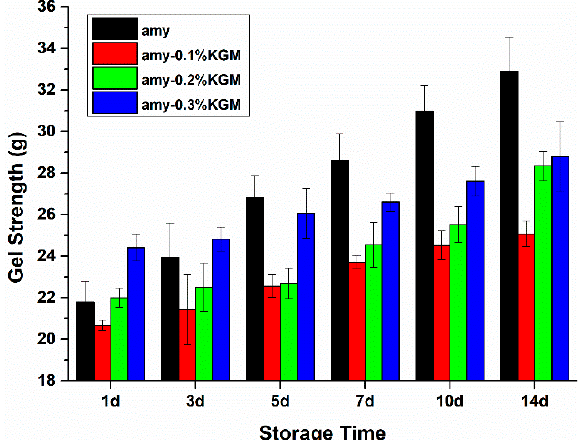
Figure 4. Gel strength of amylose–KGM mixtures at different storage times.